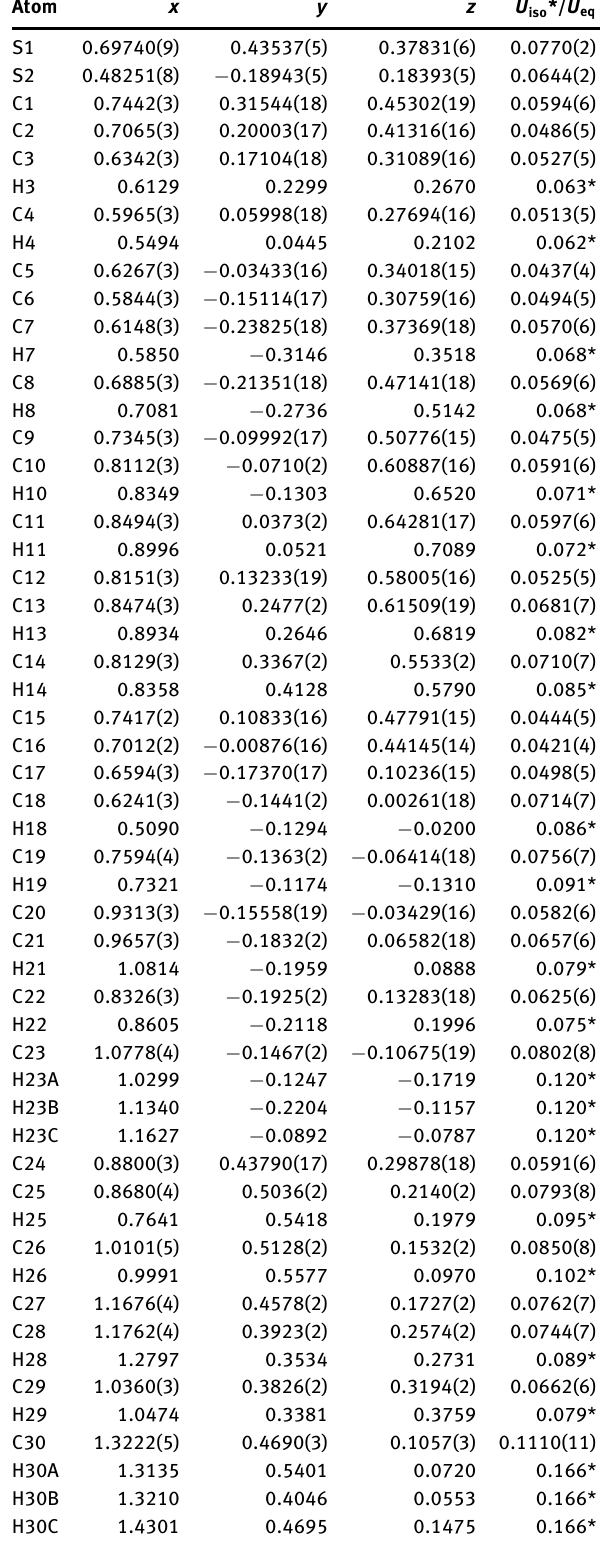
Table 2: Fractional atomic coordinates and isotropic or equivalent isotropic displacement parameters (Å 2